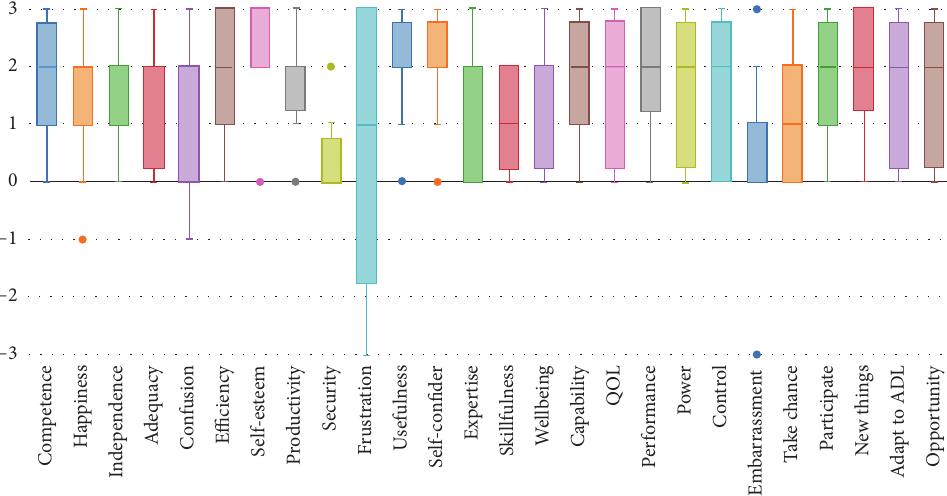
Figure 1: Box-and-whisker plot of PIADS ratings for the SaeboFlex from all